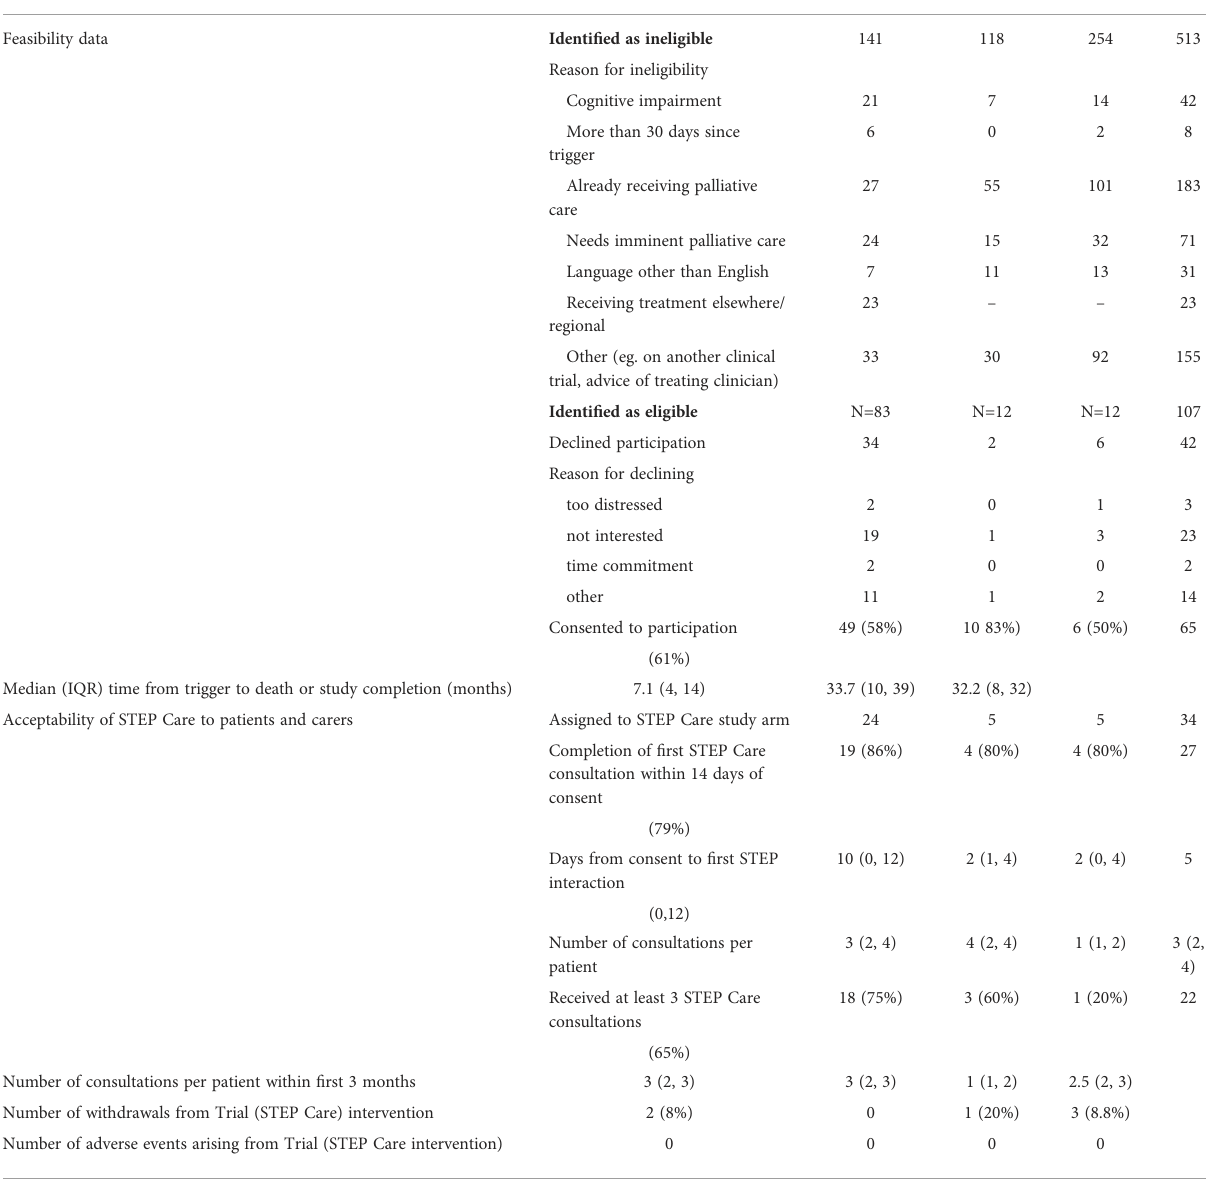
TABLE 3 Feasibility and acceptability